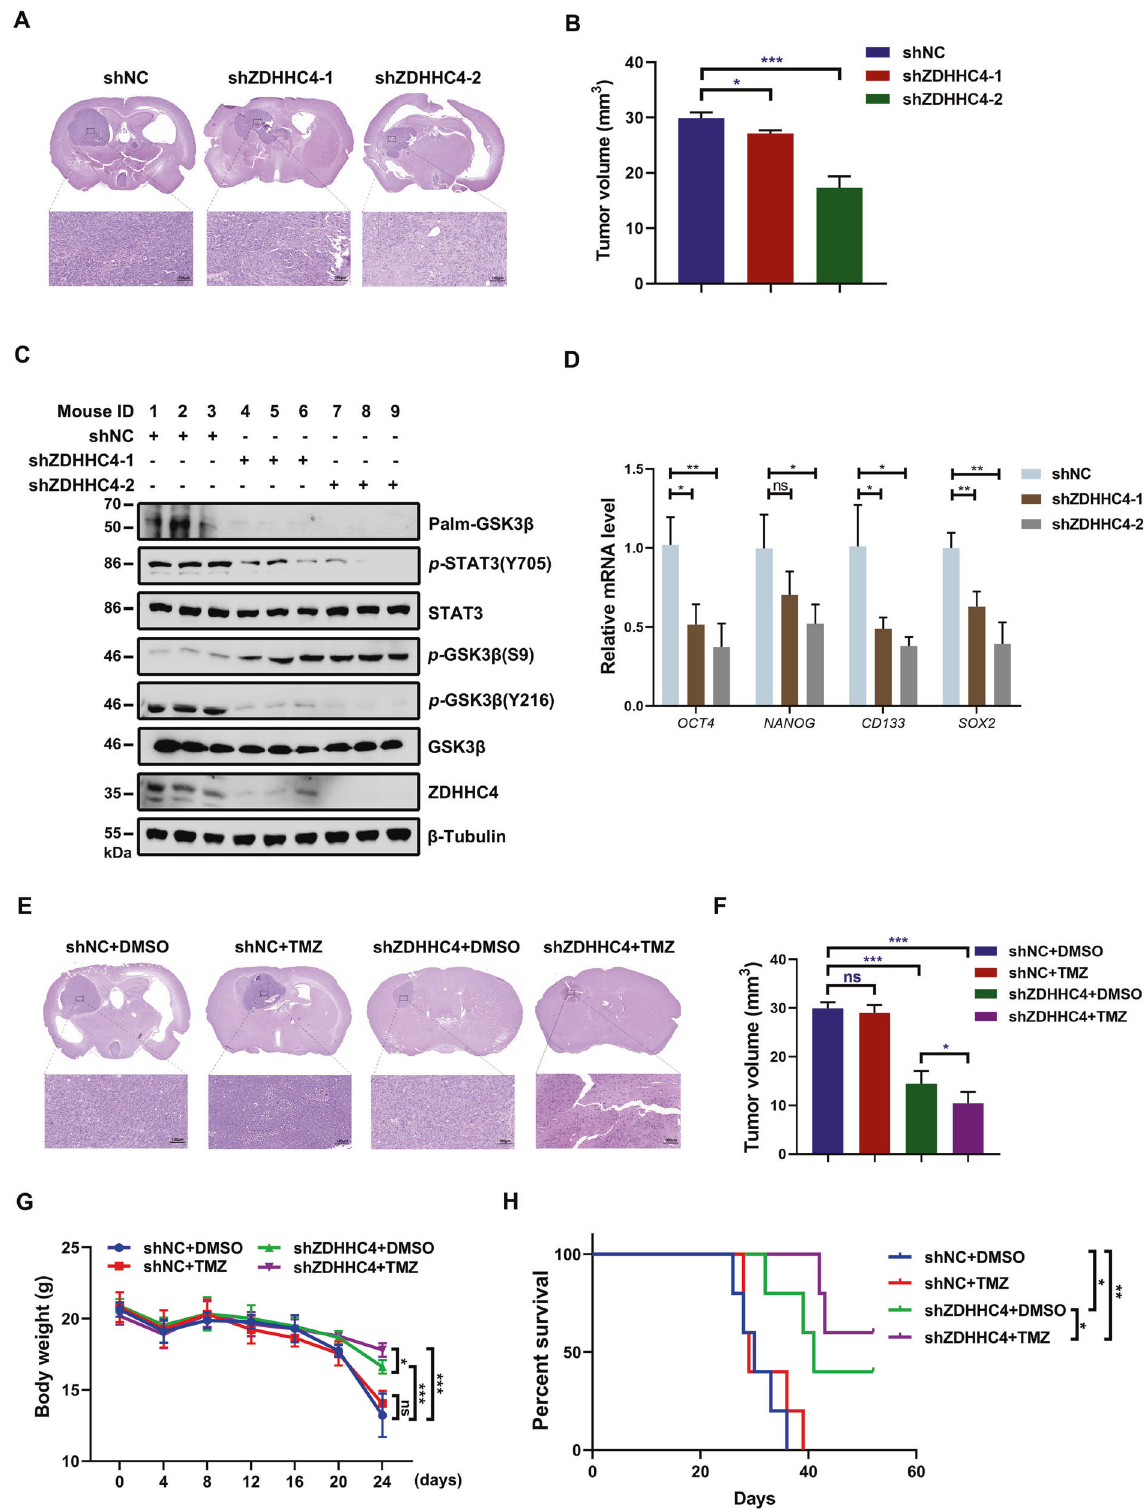
activated, and p- GSK3 β (S9) was inhibited (Fig. 3E; Supplementary Fig. 6F). The interaction of GSK3 β and EZH2 with STAT3 was also enhanced (Fig. 3F). Moreover, the ZDHHC4 – GSK3 β – STAT3 axis in two TMZ-resistant cell lines was consistently activated, which may indicate that palmitoylation of GSK3 β regulates the TMZ